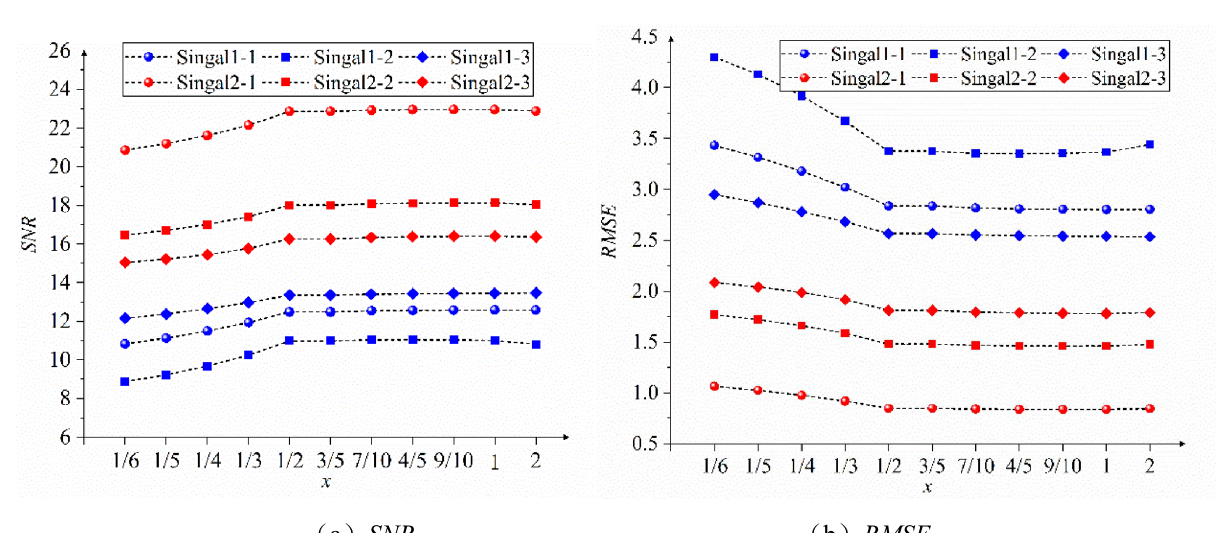
Figure 4. Test signal.